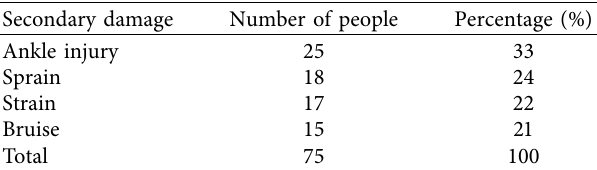
Table 4: Acute injury secondary injury